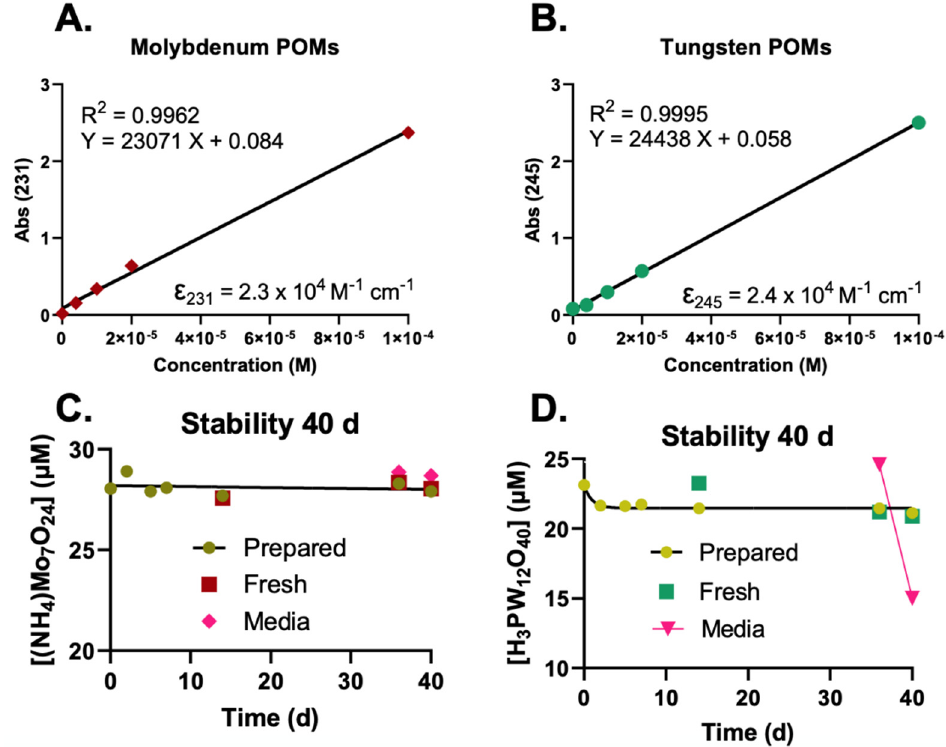
Figure 1. Molybdenum and tungsten containing polyoxometalates are stable in aqueous and buffered solutions. ( A , B ) Molybdenum ((NH 4 )Mo 7 O 24 ) and tungsten (H 3 PW 12 O 40 ) polyoxometalates were prepared (2–100 µM). The relative absorbances were plotted in an XY-plot where the slope represents the molar attenuation coefficient. ( C , D ) A 100 mM (in 0.5 M HEPES) stock solution for each POM on day 1 to test for stability. The stock was diluted to 1 mM in water to also obtain information about the stability of the POMs in aqueous environments. The aqueous solutions were further diluted to approximately 25 mM to be in an appropriate absorbance range (<1 Abs) on day 1 (Prepared). The stability was tracked for 14 days, after which a new dilution was made from the 100 mM stock (Fresh). The Mo-POM ( C ) concentration appears stable in both the 100 mM (in 0.5 M HEPES) solution in a lighted lab environment, as well as in an aqueous solution. After 35 days, a 1 mM solution was made in complete medium, then diluted to 25 mM. The solution was kept in an incubator for 4 days to reflect a maximum treatment time. The Mo-POM was both measurable in medium and stable for at least 4 days. The W-POM ( D ) concentration of the aqueous dilution dropped from ≈ 23 µM to ≈ 21 µM in the first few days. Making a fresh dilution (d = 14) shows the same effect. In contrast to the molybdenum POM, the W-POMs appear to be less stable in media over a time of 4 days, whereas the observed concentration dropped from ≈ 25 µM to ≈ 15 µM.